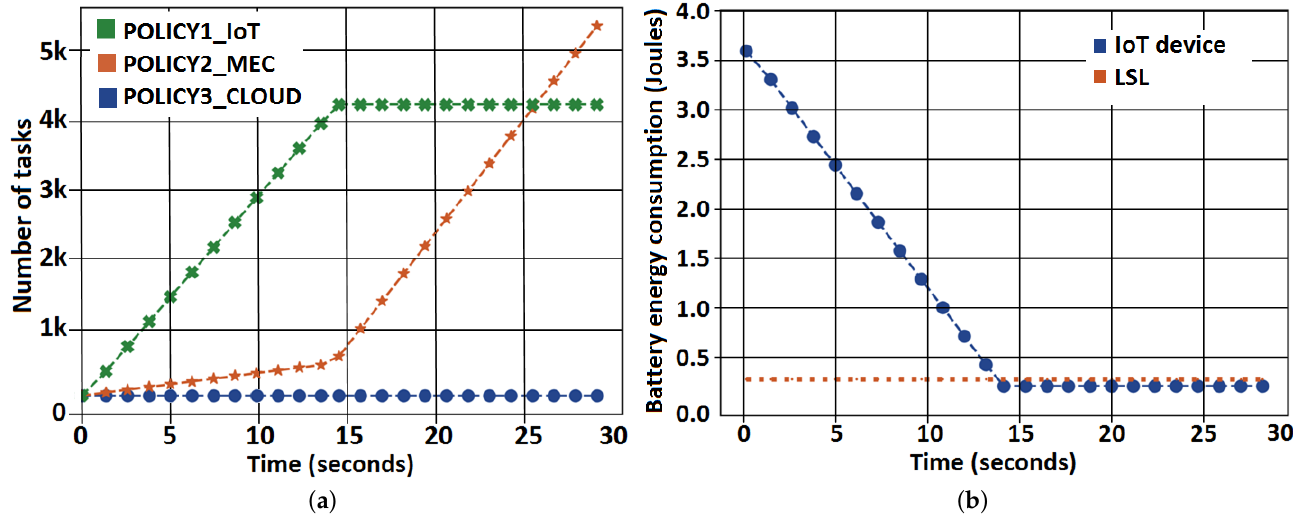
Figure 3. Task allocation behavior vs. IoT device battery energy consumption when the LSL is reached. ( a )Task allocation in the system. ( b ) Battery energy consumption of IoT devices.